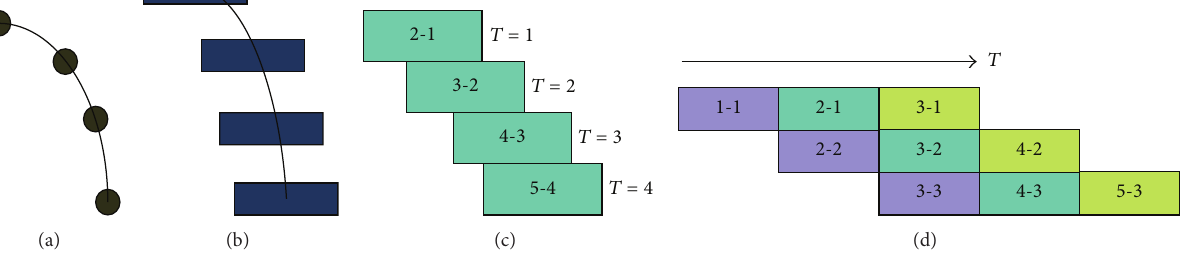
Figure 5: Natural phenomena moving like particle.